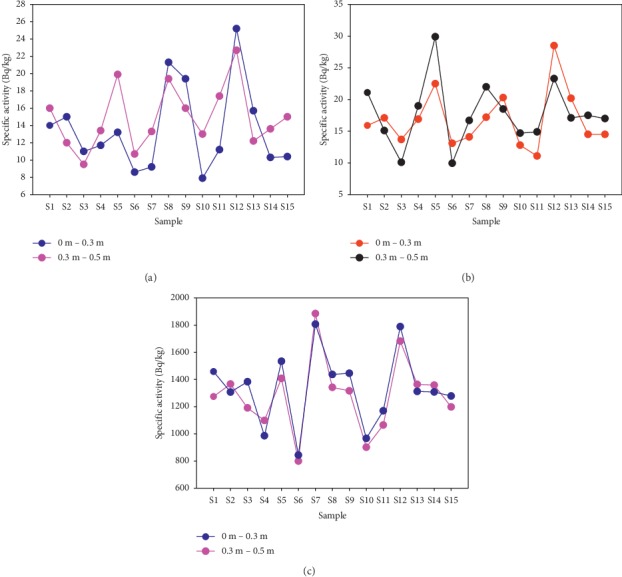
Comparison of the distribution of (a) 238U, (b) 232Th, and (c) 40K radionuclides for sand samples collected at a depth of 0 m and 0.3 m and those collected at a depth ranging from 0.3 m to 0.5 m.